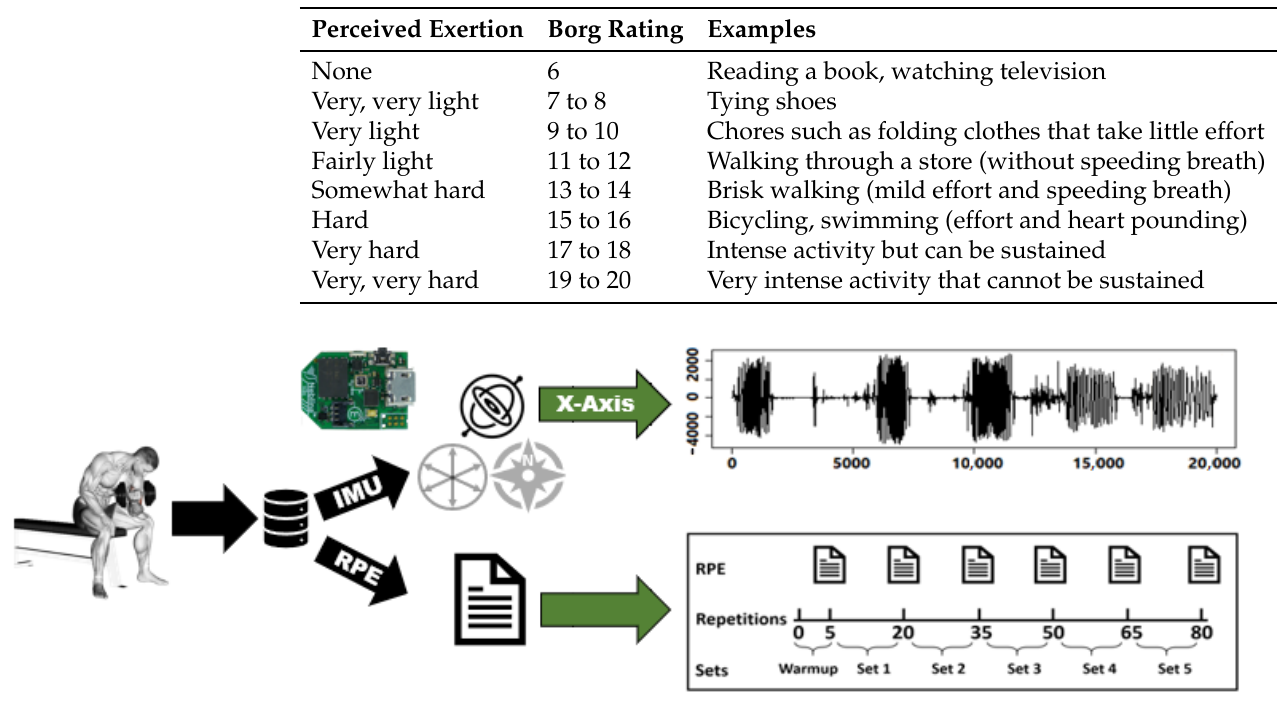
Table 1. Borg G.A. psychophysical bases of perceived exertion [49].